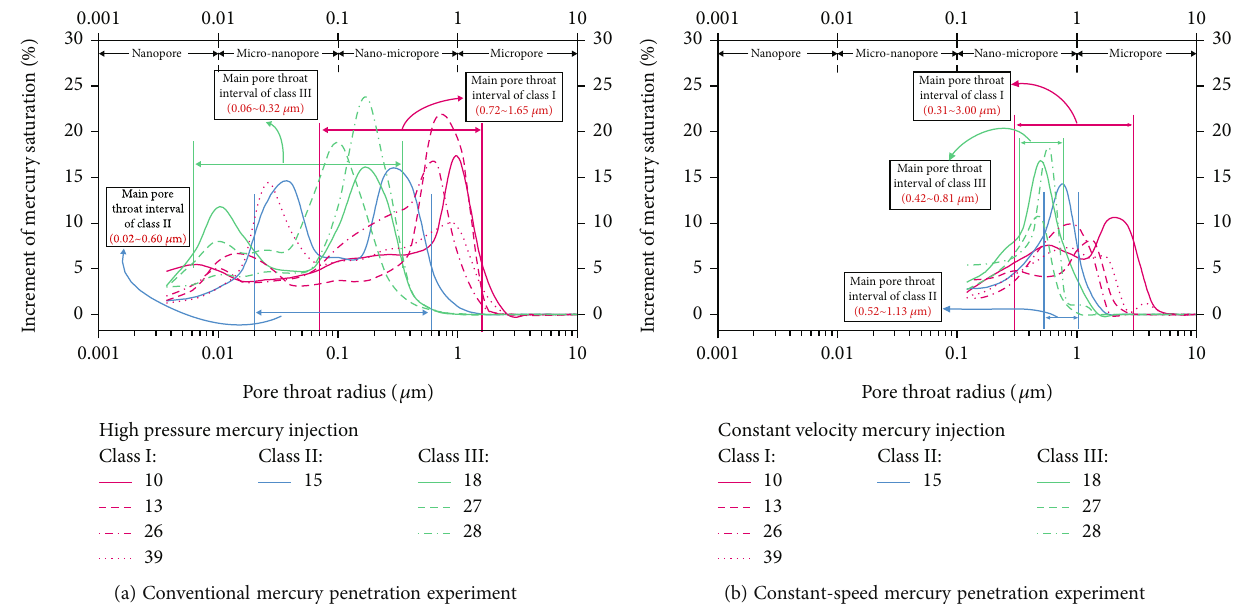
Figure 11: The frequency distribution of pore throat radius of C 6